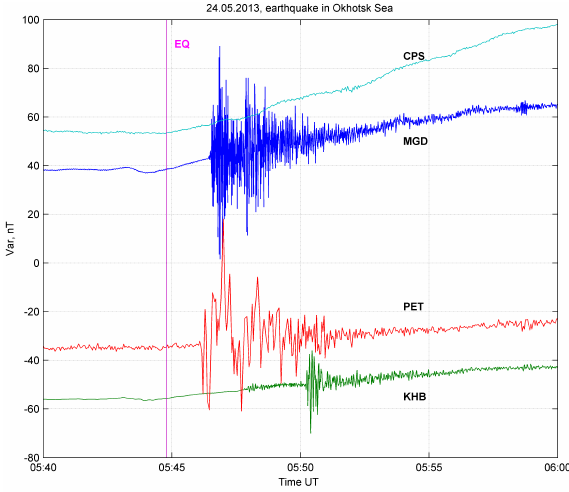
Figure 12. “Fictitious” variations of the magnetic field recorded by magnetometers with suspension system of measuring sensors: dIdD with scalar sensor in the coil system, FGE with fluxgate sensors and magnetometer Quartz-6 with Bobrov’s quartz sensors. Records obtained at CPS, MGS, PET and KHB observatories during a strong earthquake in the Okhotsk Sea on 24 May 2013 are shown. Vertical line EQ shows the earthquake